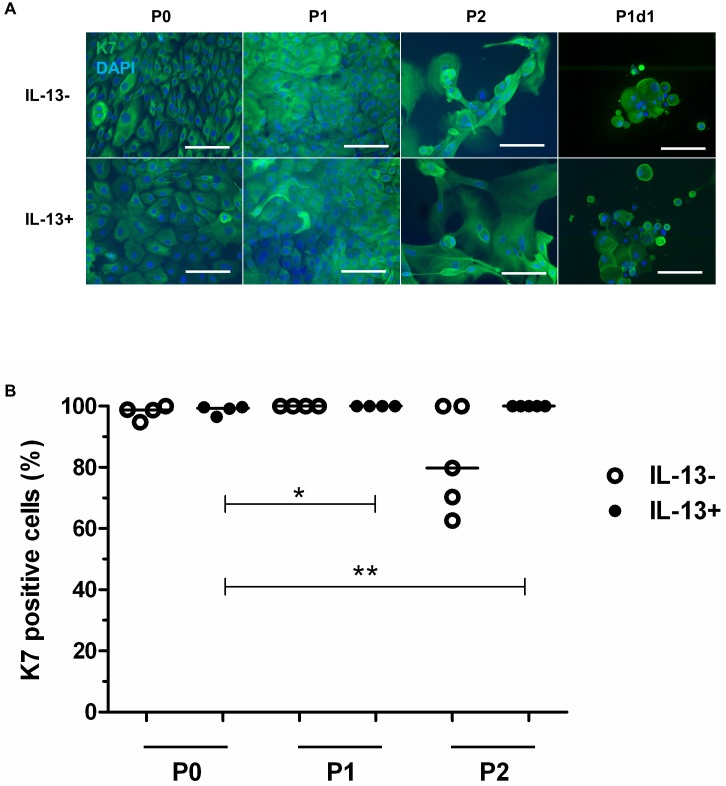
Immunofluorescent staining of K7 in IL-13- or IL-13+ cell cultures.P0 cells originating from limbal explants, P1 and P2 cells (all fixed at the end of cultivation), and the unattached GC-enriched subpopulation (P1d1, harvested on day 1 after passage of primary cells) were analyzed by immunofluorescent staining. (A) K7, green; DAPI-counterstained nuclei, blue; scale bars: 100 μm. (B) Distribution of percentages in P0, P1, and P2 groups for K7 positivity. All data of positive percentages are presented in the vertical scatter plot graph with line indicating median. *P < 0.05, **P ≤ 0.01.